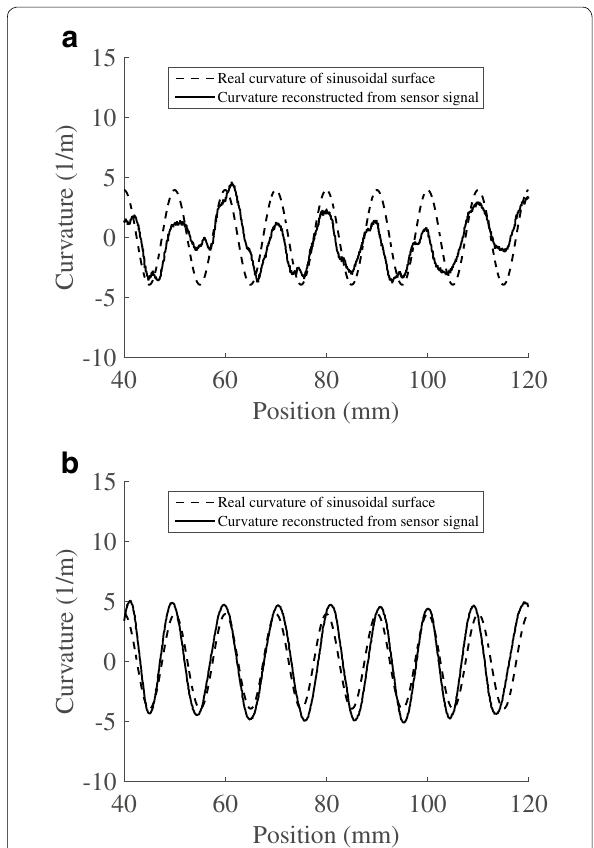
Fig. 6 Comparison between actual and estimated curvature. Each graph shows the output signal of ( a ) a conventional sensor (without a flexible structure) and b our proposed sensor (with a flexible